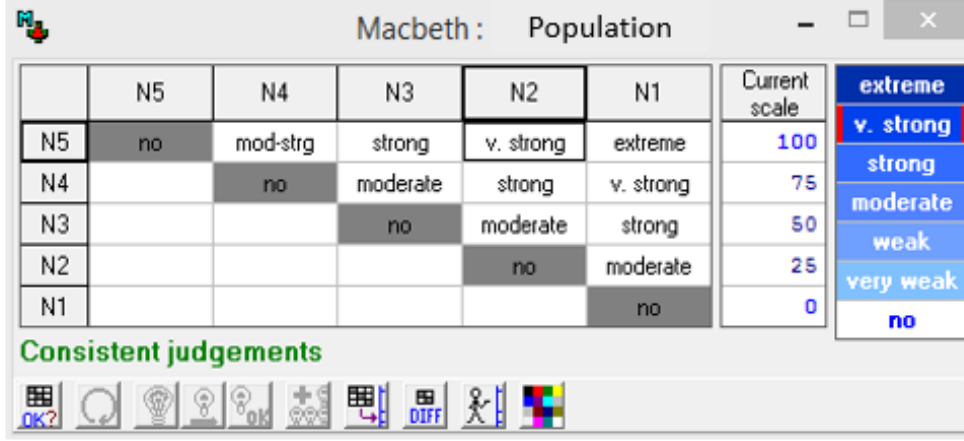
Figure 3. Value functions of FPV 1—population of the immediate region.